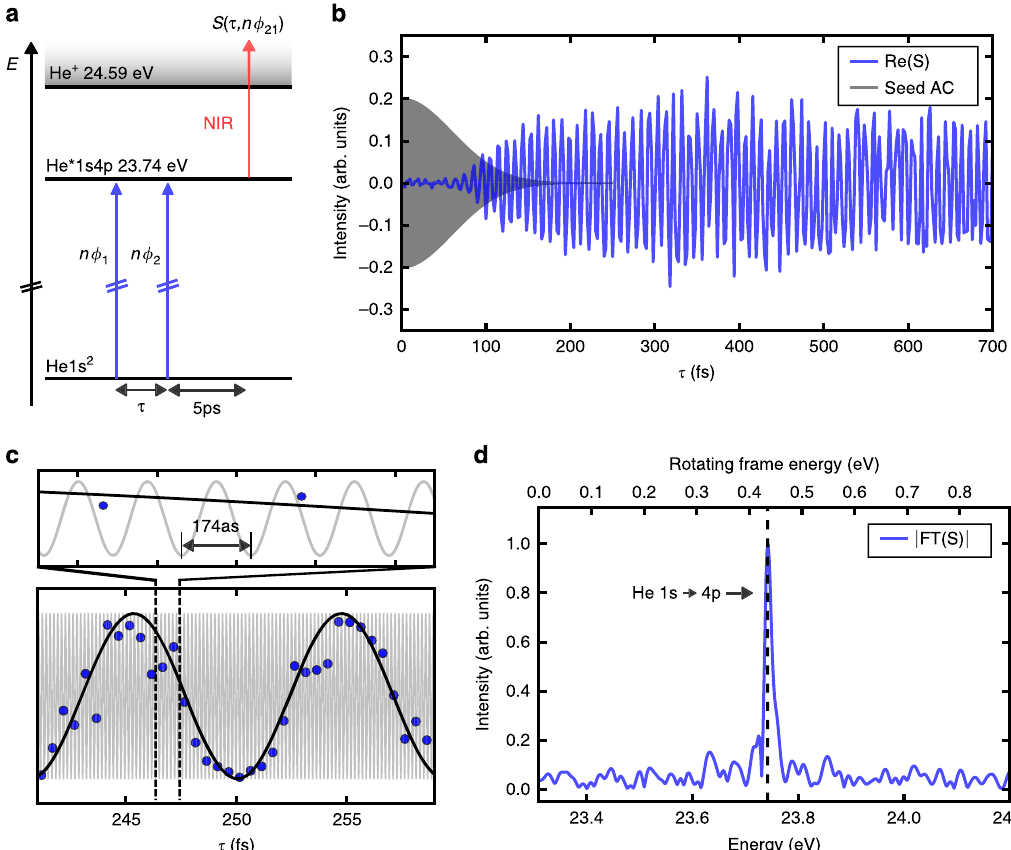
Fig. 3 XUV electronic coherence in helium. a Energy scheme of helium with relevant levels and interaction pathways. b Real part of the downshifted WP signal, with the delay incremented in 2 fs steps. Temporal overlap region of seed pulses is indicated (gray area). Each data point corresponds to only 640 consecutive FEL shots, no additional data fi ltering was applied. c Data points taken with delay increment of 500 as (blue) compared to downshifted oscillation frequency of the excited transition (black). For comparison, the gray curve shows the theoretical rapid oscillation, that would be obtained without rotating frame detection ( T = 174 as, see also inset). Due to rotating frame detection, we get a frequency downshift by a factor of ≈ 52, transferring the attosecond beats to the femtosecond regime. d Fourier transform (absolute value) of the signal, showing the He 1s → 4p resonance. The upper energy scale shows the downshifted frequency range obtained by rotating frame detection, the lower energy scale shows corresponding absolute energy